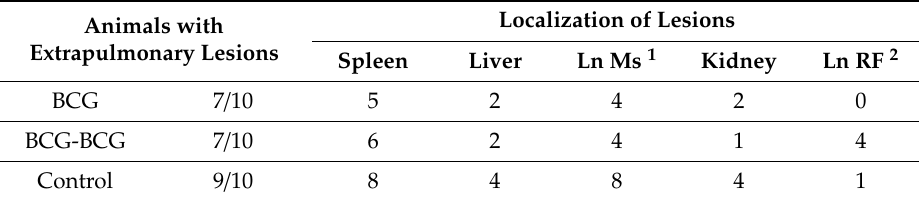
Table 2. Extrapulmonary